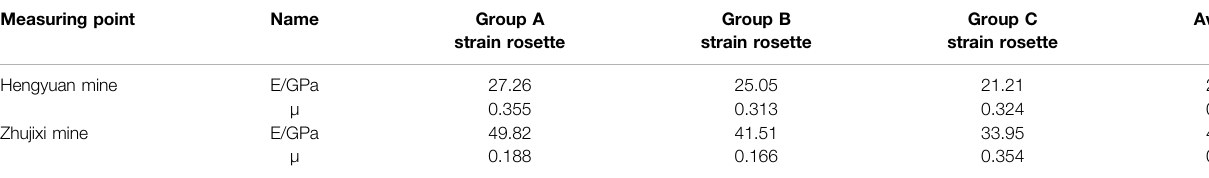
TABLE 1 | Rock mechanical parameters selected in in situ stress calculations.